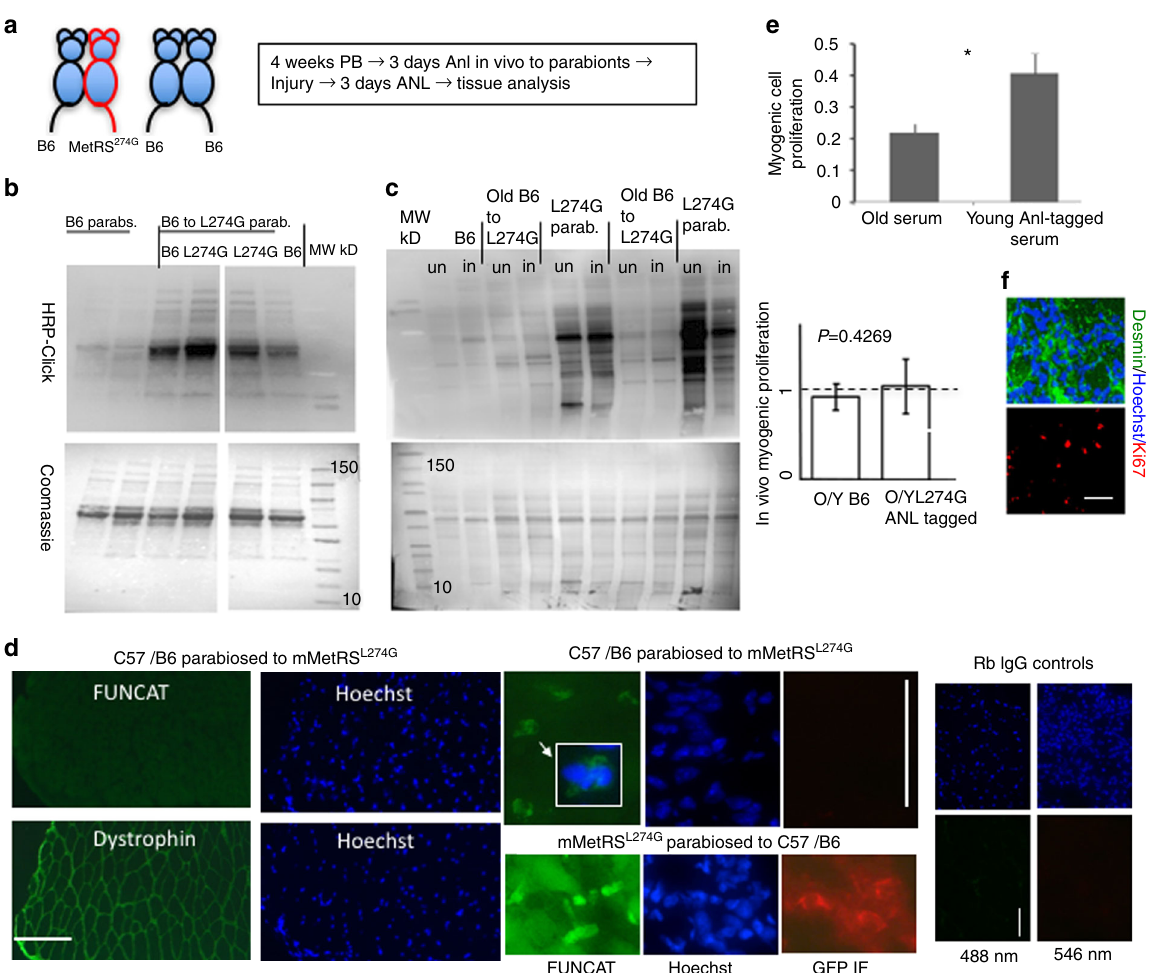
Fig. 4 Bio-orthogonal proteome labeling in the setting of heterochronic parabiosis. a Schematic representation of the study. b Click-western blotting on serum proteins from the heart-bleeds of MetRS L274G parabionts and their C57BL/6 partners and the negative control syngeneic C57BL/6 pairs. c Click-western blotting resolved the robust selective in vivo ANL-labeling of the proteomes from uninjured (un) and injured (in) Gastrocnemius muscle of MetRS L274G parabionts (Parabs) and much lower ANL-labeling of proteins that were derived from muscle of their C57BL/6 partners; however, this signal was above the background of the negative control, syngeneic C57BL/6 pairs. Coomassie blue staining demonstrates equal protein loading. Similar results were obtained in at least three independent experiments with each cohort. d FUNCAT assay in 10-micrometre muscle cryosections from the indicated parabiotic cohorts has con fi rmed the selectivity of ANL-labeling of MetRS L274G proteome in settings of parabiosis. A few mono-nucleated cells with FUNCAT signal above that of the nearby tissue were identi fi ed in the C57BL/6 muscle (20× image and an enlarged overlay). These FUNCAT + cells were not MetRS L274G leukocytes, as per negative GFP immunostaining ( red ). Scale bar , 100 μ m. Similar results were obtained in three old C57BL/6 mice independently parabiosed to young MetRS L274G mice and analyzed by FUNCAT. e Proliferation rates of old C57BL/6 satellite cells were compared in culture, in presence of serum from young MetRS L274G mice that were administered with ANL in vivo versus the serum from old C57BL/6 mice. Shown are means and SD; N = 3, P < 0.05 (two-tail Student t -test). f Muscle regenerative index (the numbers of proliferating Ki67 + Desmin + myogenic cells) at 3-days post CTX injury; all parabionts were administered ANL in vivo. Representative immunostaining images are shown in right panels and quanti fi cation of the percent in vivo myogenic cell proliferation normalized to the percent myogenic cell proliferation in young muscles that is set at 1 ( dashed line ), is shown in the left panel bar graph. Shown are means and SD. N = 3, P = 0.426908 (two-tail Student t -test). C57BL/6 versus young MetRS L274G . Scale bar